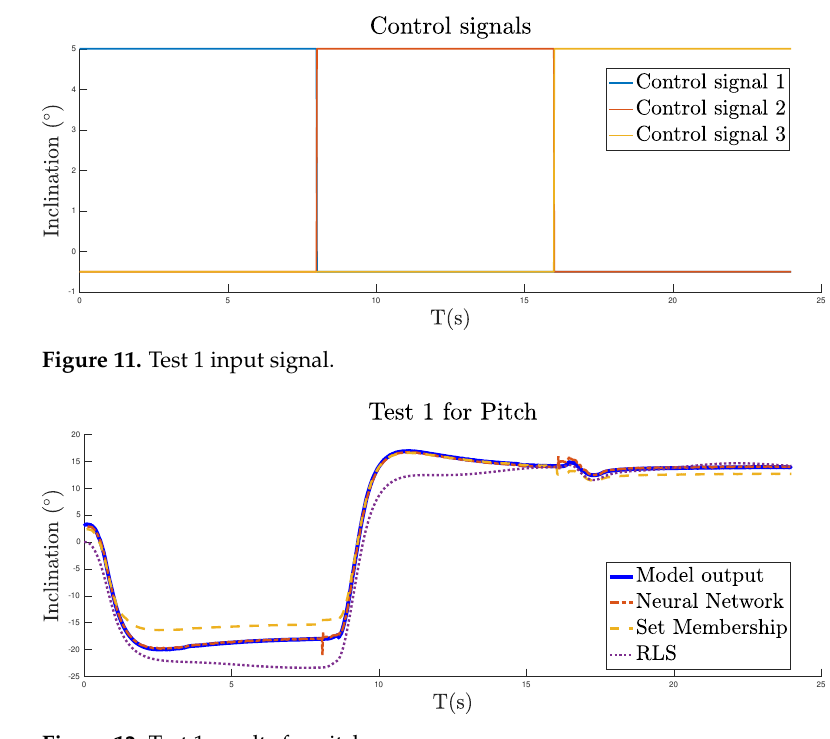
Figure 12. Test 1 results for